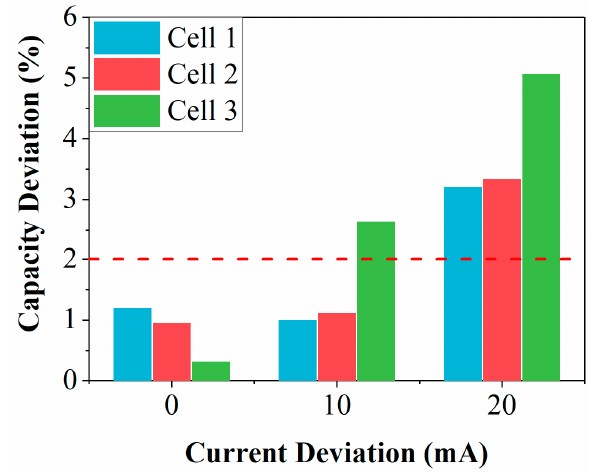
Figure 8. The capacity deviation for different cells.